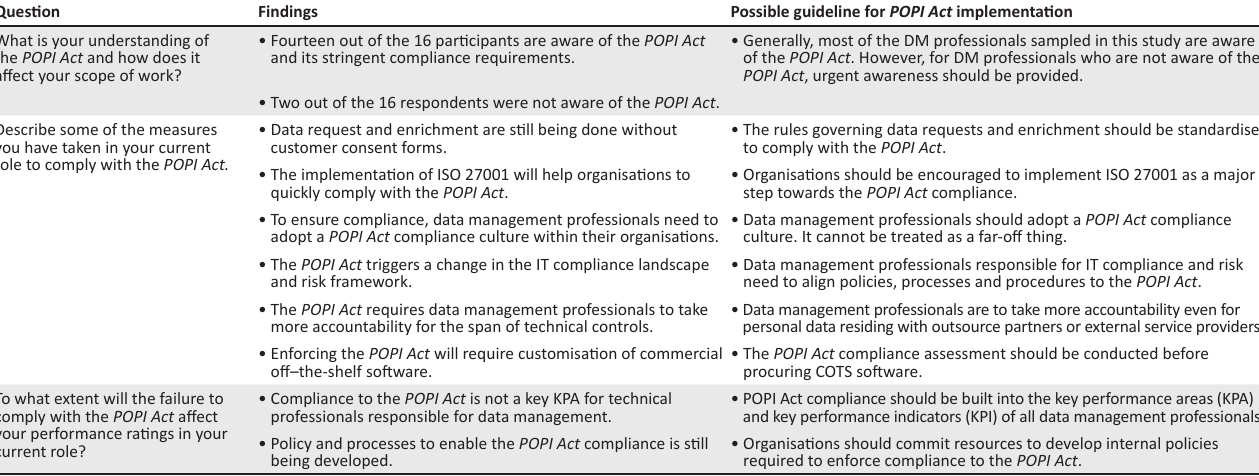
TABLE 4: Summary of findings and guidelines for Protection of Personal Information Act enforcement.